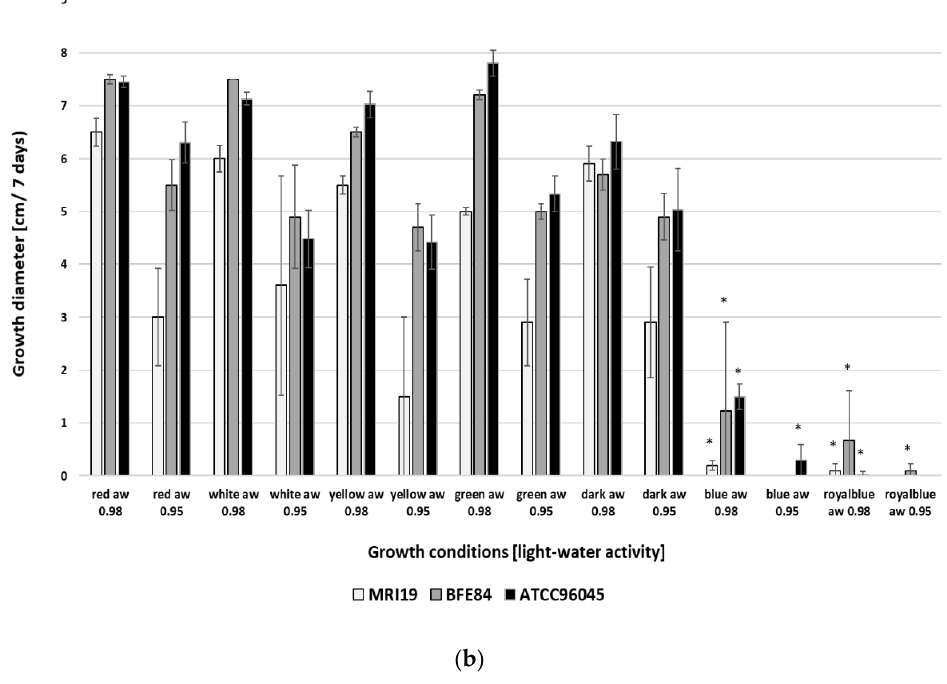
Figure 1. ( a ) Phenotypic growth of the analyzed Aspergillus isolates dependent on different combinations of light and water activity. ( b ) Growth rates of the analyzed Aspergillus isolates dependent on different combinations of light and water activity. Standard deviations are given for each parameter. * = The growth was significantly reduced in relation to the control (dark).